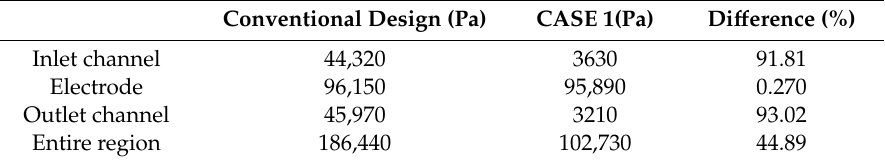
Figure 16. Flow distribution for CASE 2.